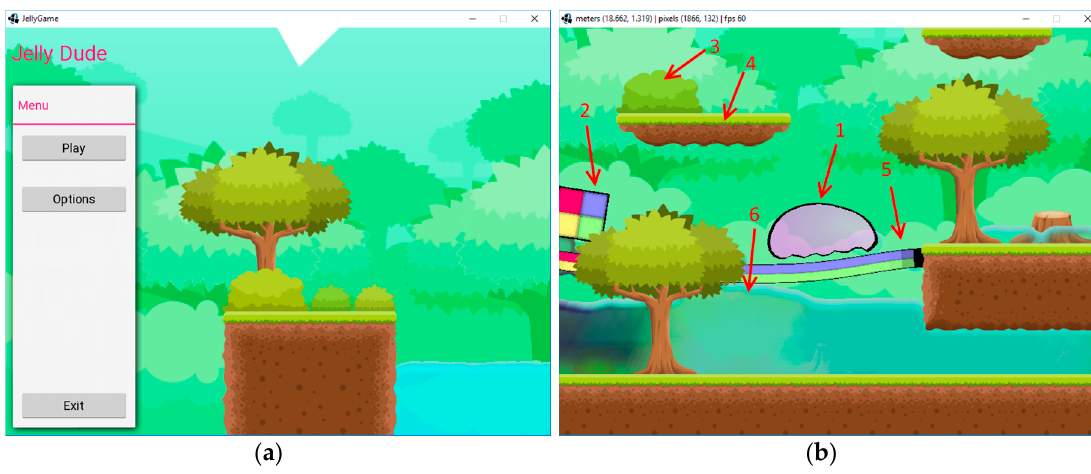
Figure 5. ( a ) The main menu of the game (left); ( b ) elements visible during the game (right). (1) Player-operated character. (2) Soft bodies to which you can stick with the main character. (3) Background objects that cannot be touched. (4) Solid immovable objects and obstacles. (5) Soft bridges to which one can stick with the main character. (6) Simulated water.